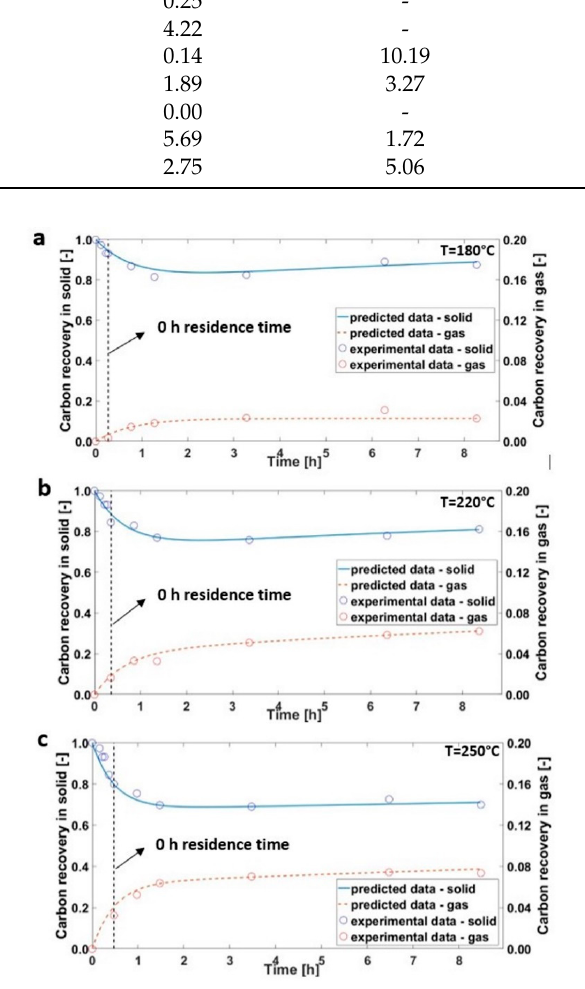
Figure A3. Carbon recovery in solid and gas phases for olive trimmings fixing n = 1: ( a ) 180 °C, ( b ) 220 °C, and ( c ) 250 °C.